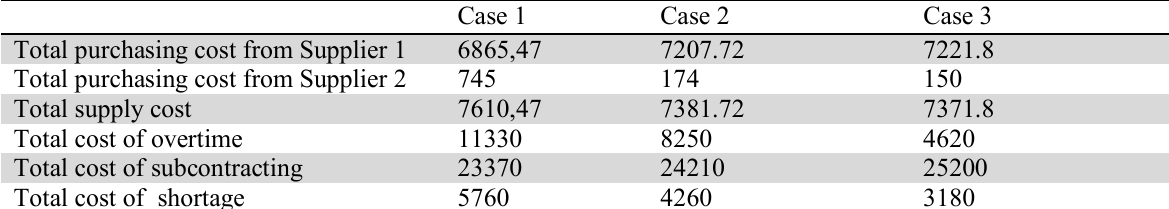
Operational costs for the three case studies